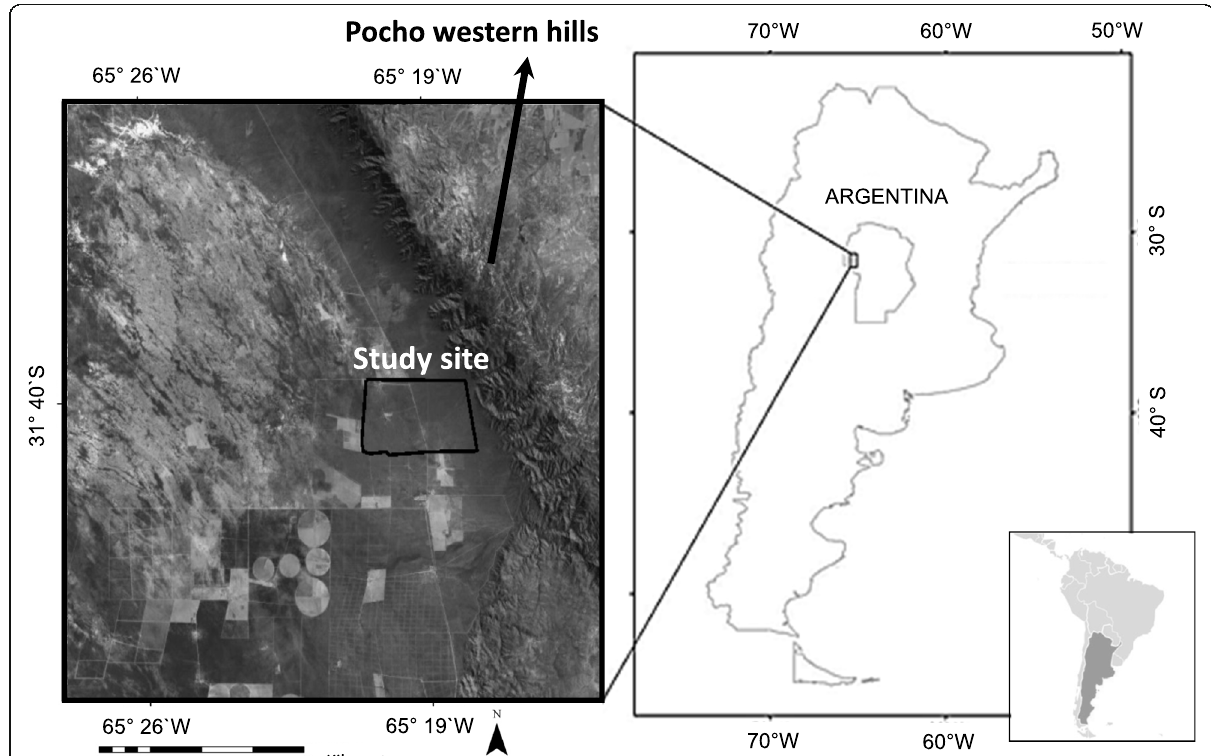
Fig. 1 Location of the study site (black polygon) at the foothills of Pocho western hills, Córdoba province,